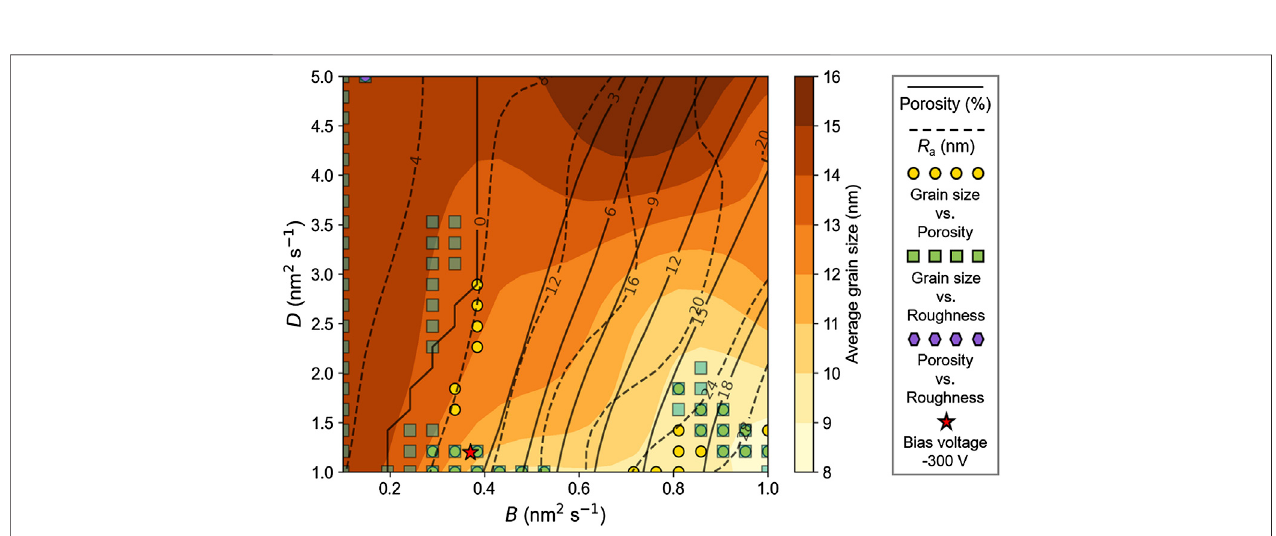
FIGURE11| Screeningwindowofthemodelparametersforbestcoatingpropertycombinationsofgrainsize,porosity,andsurfaceroughness,comparedwiththe best experimental result (Wang et al., 2015).